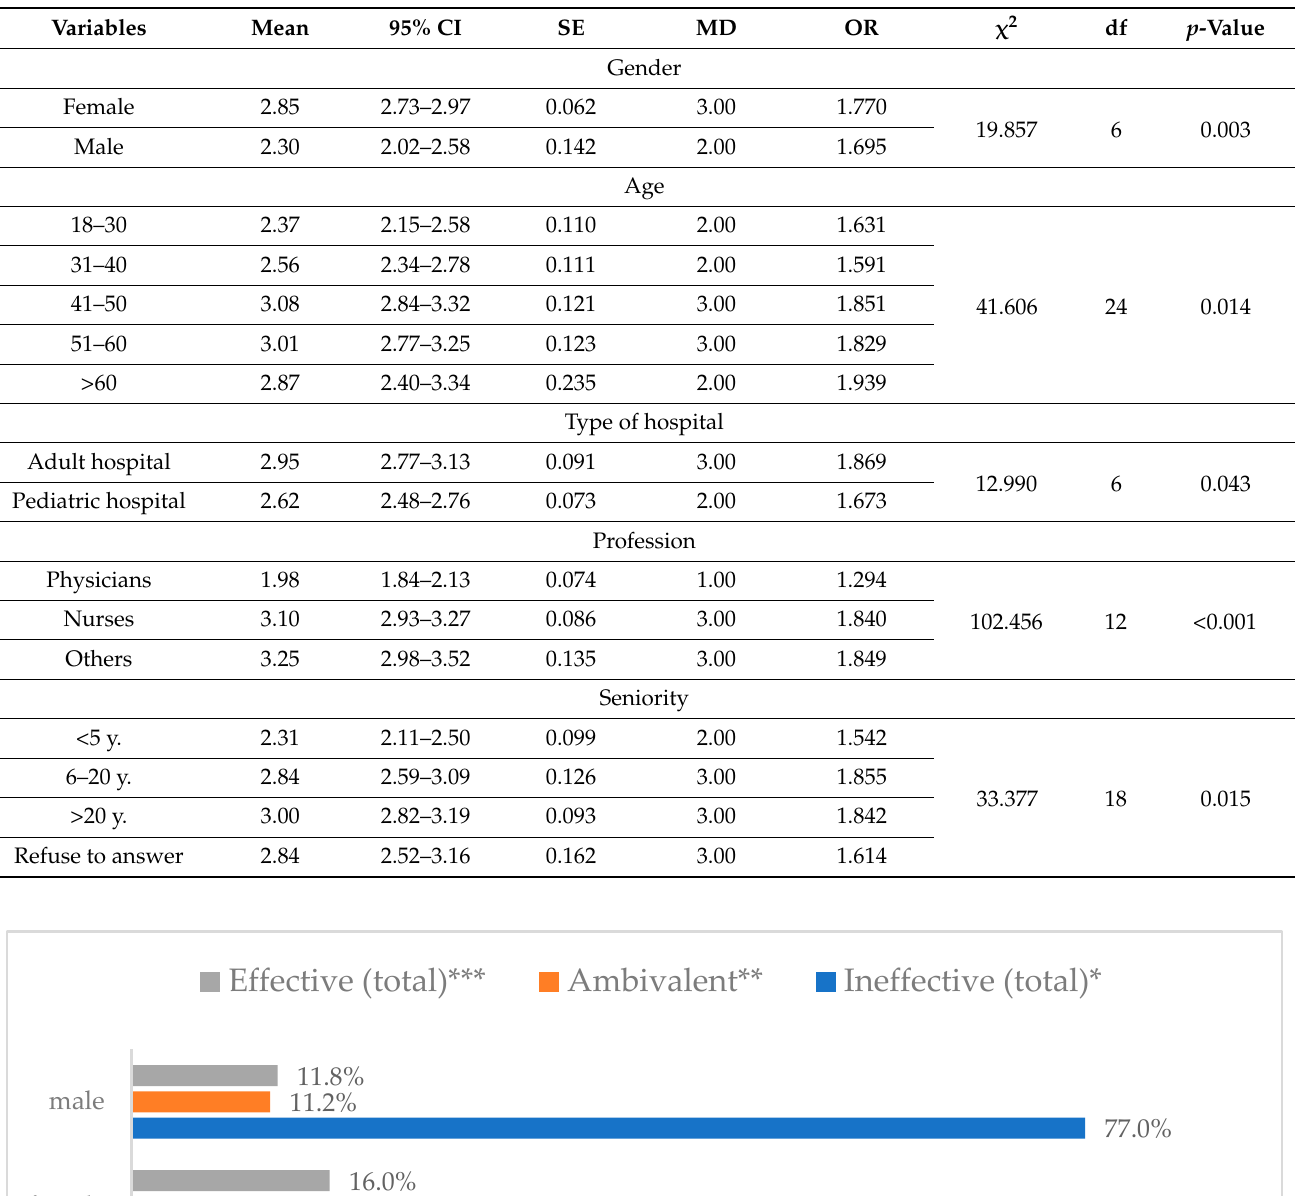
Table 7. Evaluation of eating garlic to prevent influenza virus infection by sociodemographic category ( N = 950).